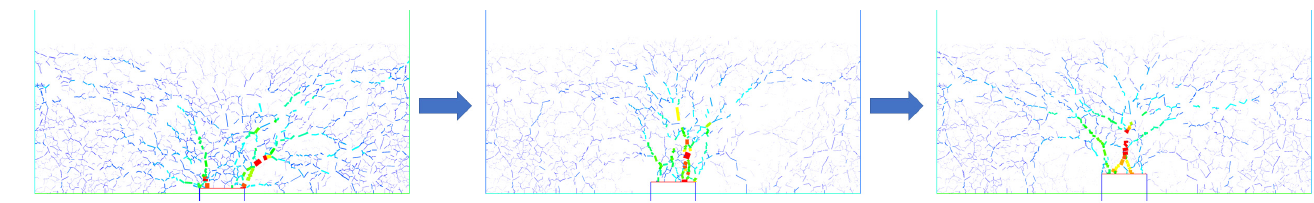
Figure 13. Evolution of force chain grid.